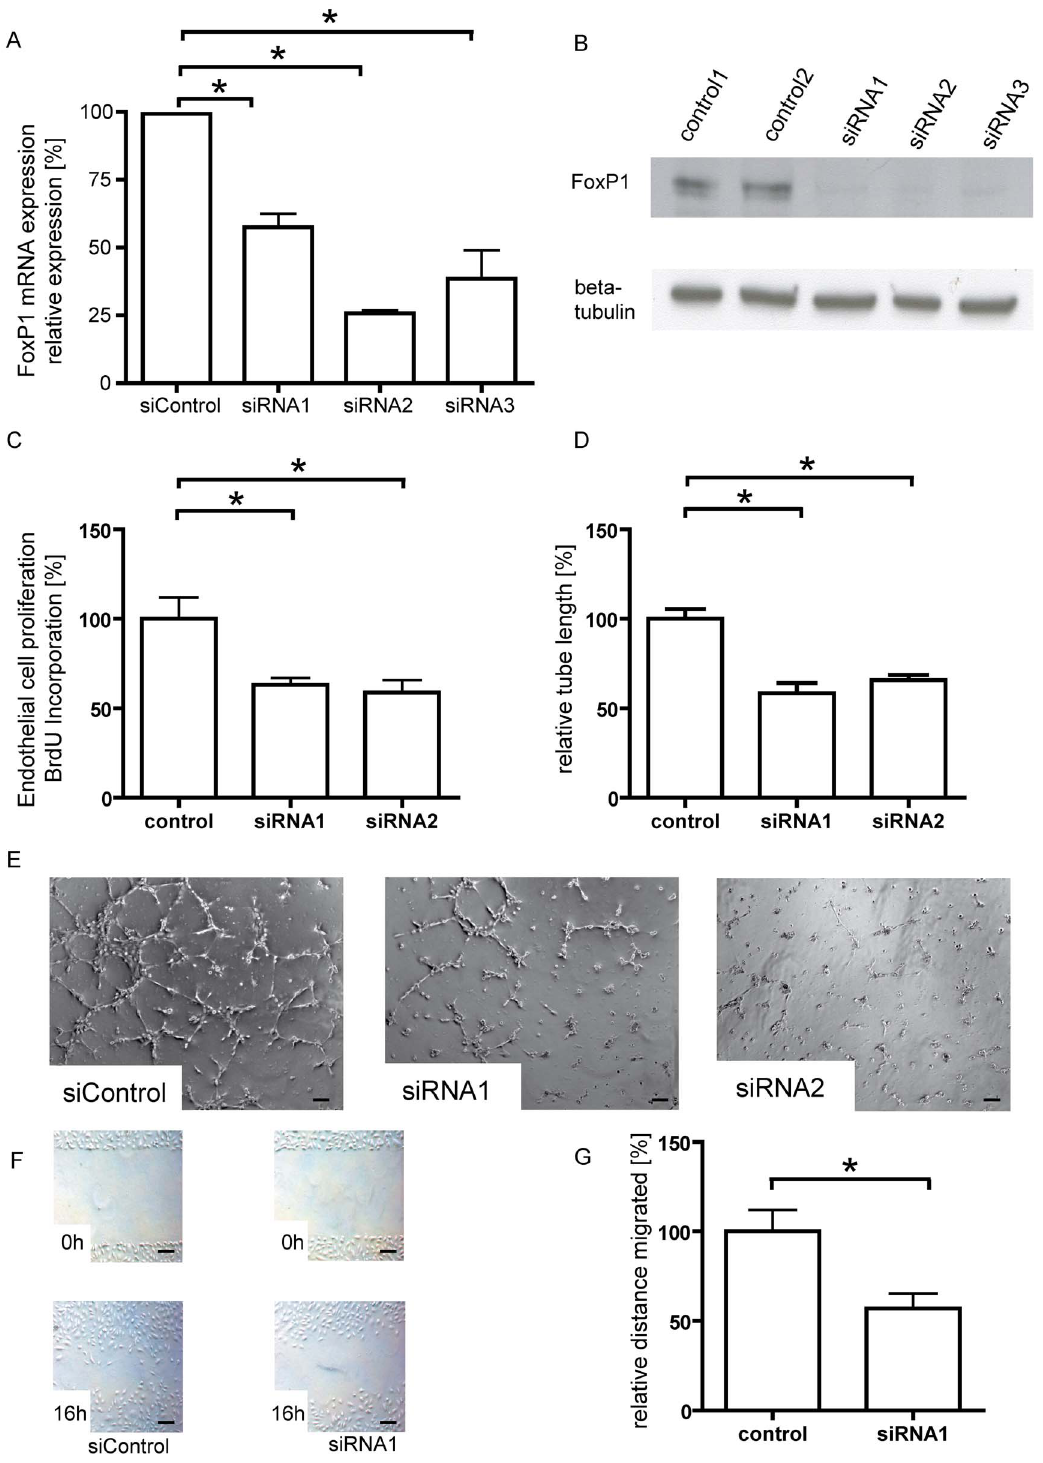
Figure 2. FoxP1 knockdown attenuates endothelial cell proliferation, tube formation and migration. Human umbilical vein endothelial cells were transfected with three different siRNA oligonucleotides against FoxP1, which resulted in a significant reduction of FoxP1 expression on both mRNA (A) as well as protein level (B) compared to transfection with a control siRNA. (C) Reduction of FoxP1 levels by two different siRNAs resulted in a significant attenuation of endothelial cell proliferation. (D&E) For quantification of endothelial tube formation, transfected cells were cultured on matrigel and cumulative sprout length of capillary-like structures was measured after 3 hours. FoxP1 knockdown attenuated angiogenic tube formation, with a shorter total tube length compared to transfection with a control siRNA. (F + G) FoxP1 knockdown resulted in a significant inhibition of endothelial cell migration in the planar wound healing assay. (*=p , 0.05, Scale bars: 100 m m).